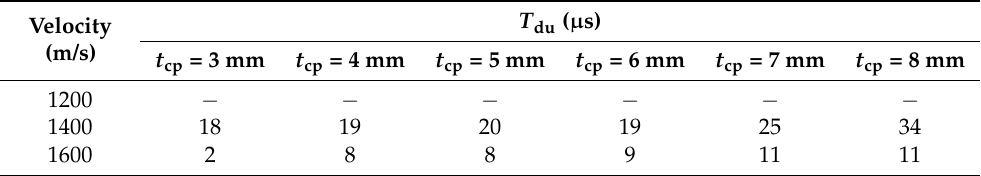
Table 5. Dwell duration in cases with the fixed cover plate.